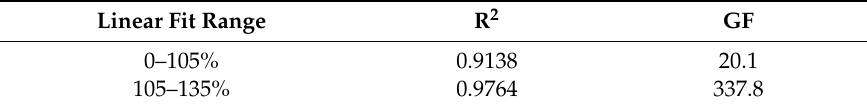
Figure 5. The characteristics of the strain sensor under stretching mode. ( a ) Experimental pictures of the device. ( b ) Resistance variation of the device under various tensile strain. ( c ) Resistance variation of the device under tensile strain and released conditions. ( d ) Response of the strain sensor under various strain conditions. ( e ) Response of the strain sensor under different frequency conditions. ( f ) Stability test of the device. Table 2. The key parameters of this strain